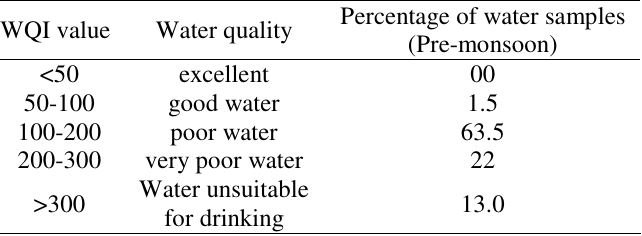
Table 4 . Water quality classification based on WQI value